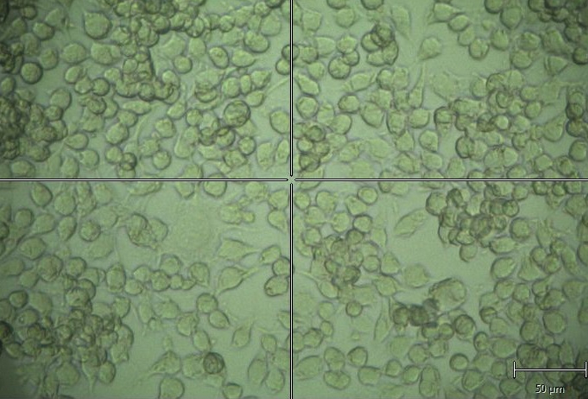
Figure 1. Example of the studied cell culture.